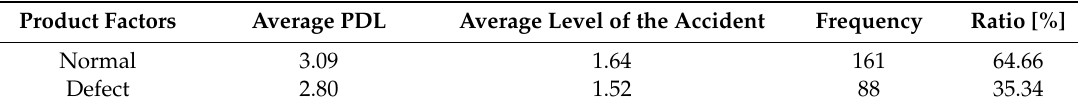
Table 5. Episode distributions relying on the “product